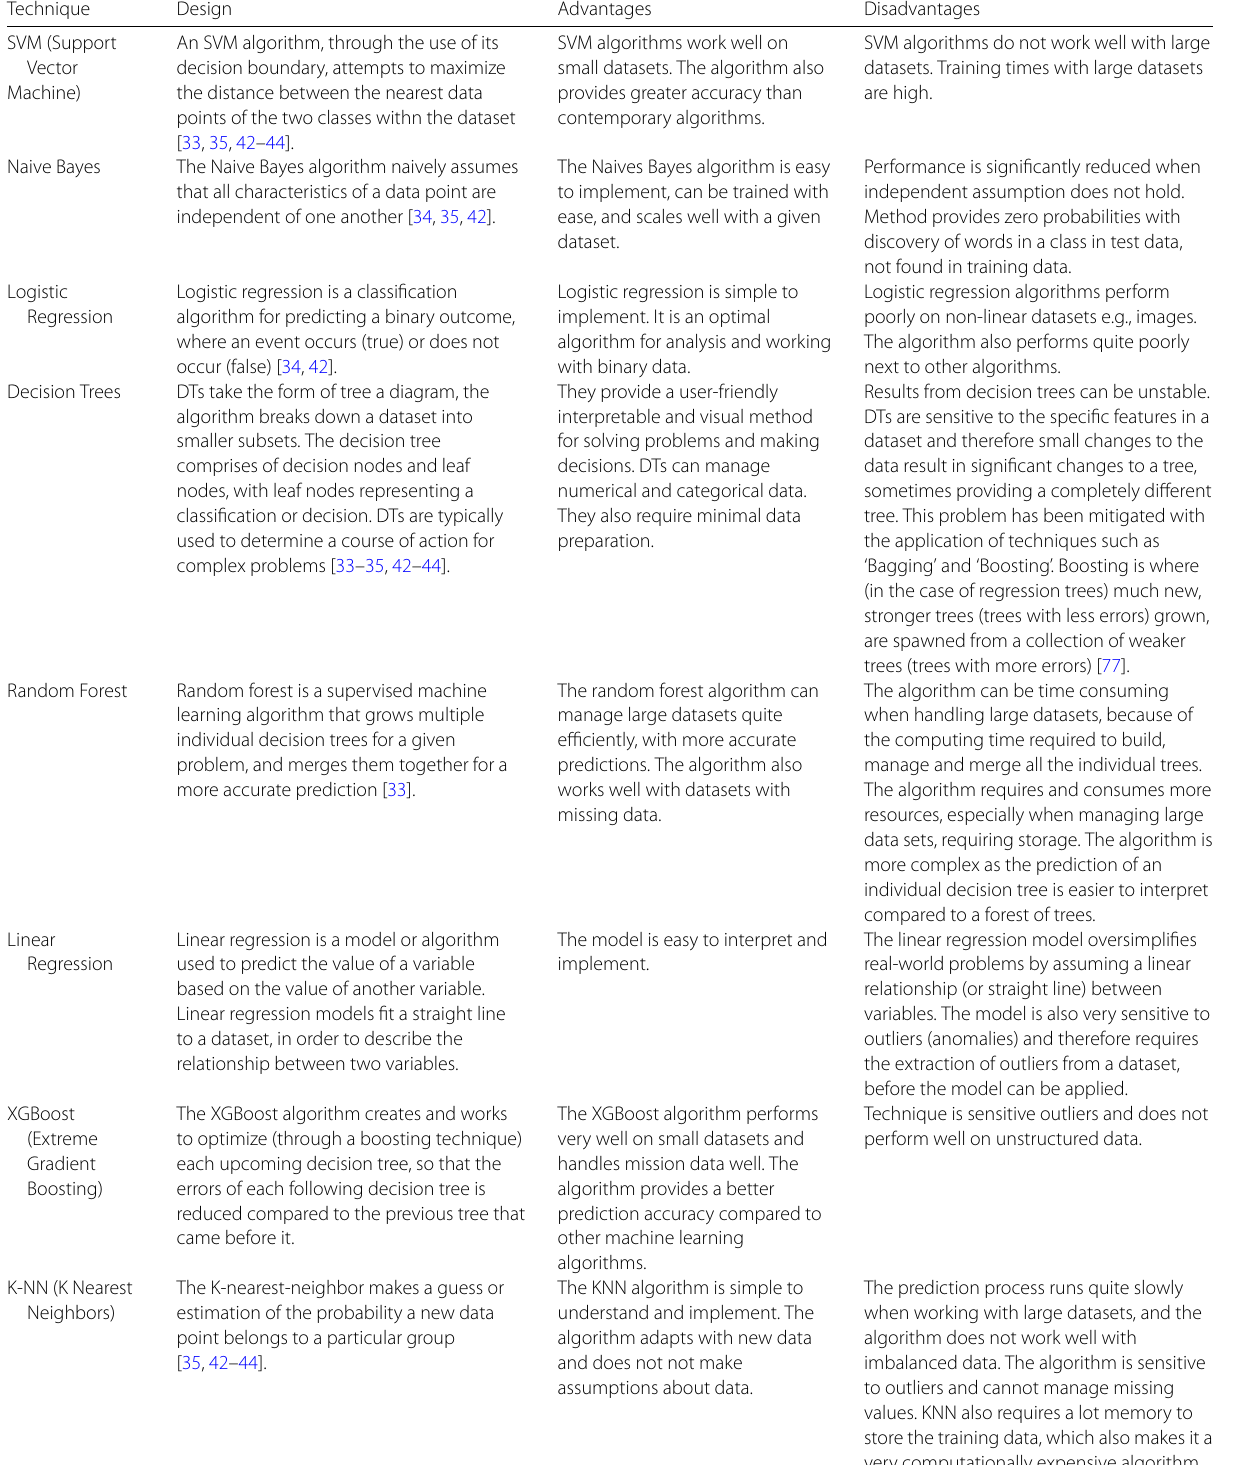
Table 1 Review of advantages and disadvantages of different Machine Learning techniques